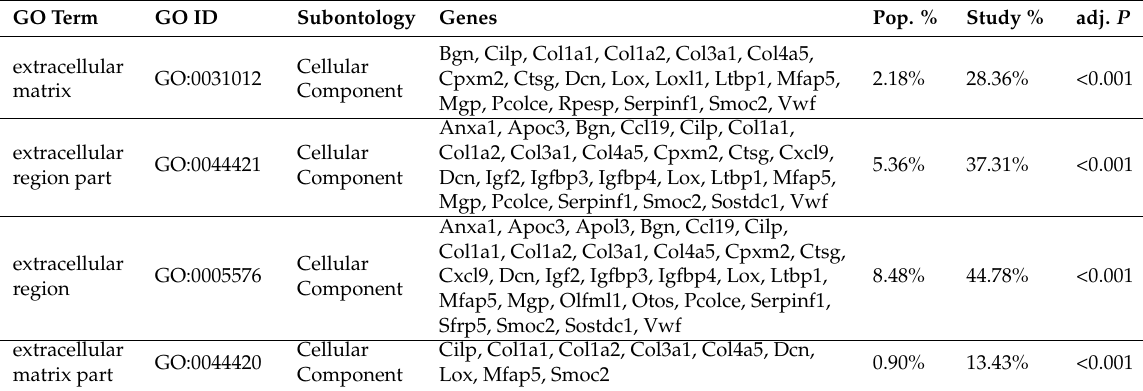
Figure 2. Significant genes in immediate PRF treatment. Comparison of gene expression in rats from the SNI and SNI + immPRF groups at various times. A total of 80 genes with significant differential expression (>2-fold, p < 0.05) were found from the microarray hybridizations. Three genes ( Ckm , RGD1591759 , and Igf2 ; indicated by red triangle) with ERK- or MAPK-related GO terms were separated according to the Web-based gene ontology annotations (http://david.abcc.ncifcrf.gov). Table 1. Four enriched GO terms were filtered according to Parent–Child–Union—Bonferroni criteria (adjusted p < 0.001).